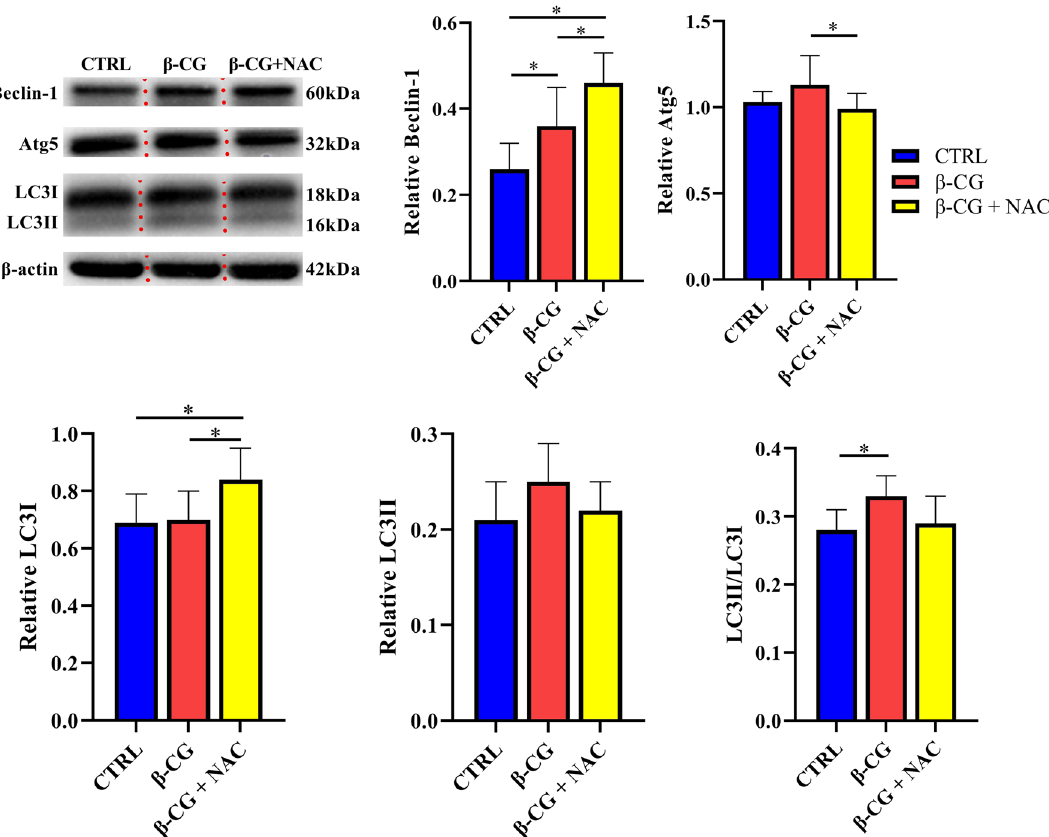
Figure 8. Protein abundances of beclin-1, Atg5 and LC3 (LC3I and LC3II) in the jejunal mucosa of piglets (full length blots are shown in Supplementary Figure S7-S10). Approximately 100 mg of jejunal mucosal samples were powdered and homogenized in lysis buffer. After centrifugation, the mucosal samples were separated by 10% (for β-actin) or 12% (for Atg 5, beclin-1 and LC3) SDS-PAGE and electroblotted onto polyvinylidene difluoride membrane. Thereafter, membranes were incubated with a primary antibody and a secondary antibody as described in MATERIALS AND METHODS. Data are mean ± SEM, n = 8. * P <